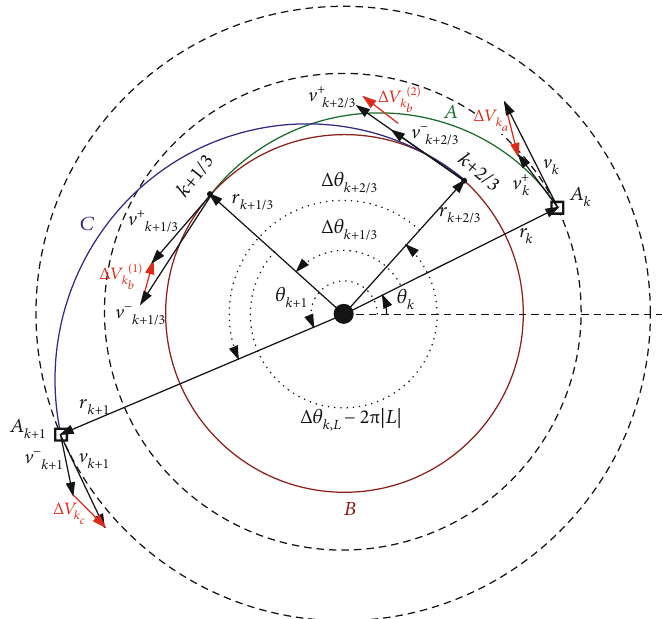
Figure 1: Trajectory sketch for the ð k + 1 Þ -th